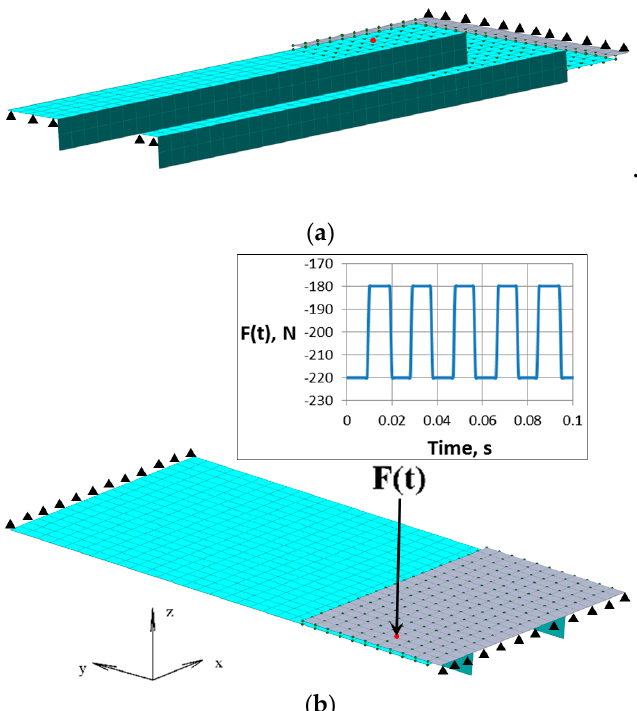
Figure 4. Model of the aircraft panel assembly. ( a ) Bottom view. ( b ) Top view.